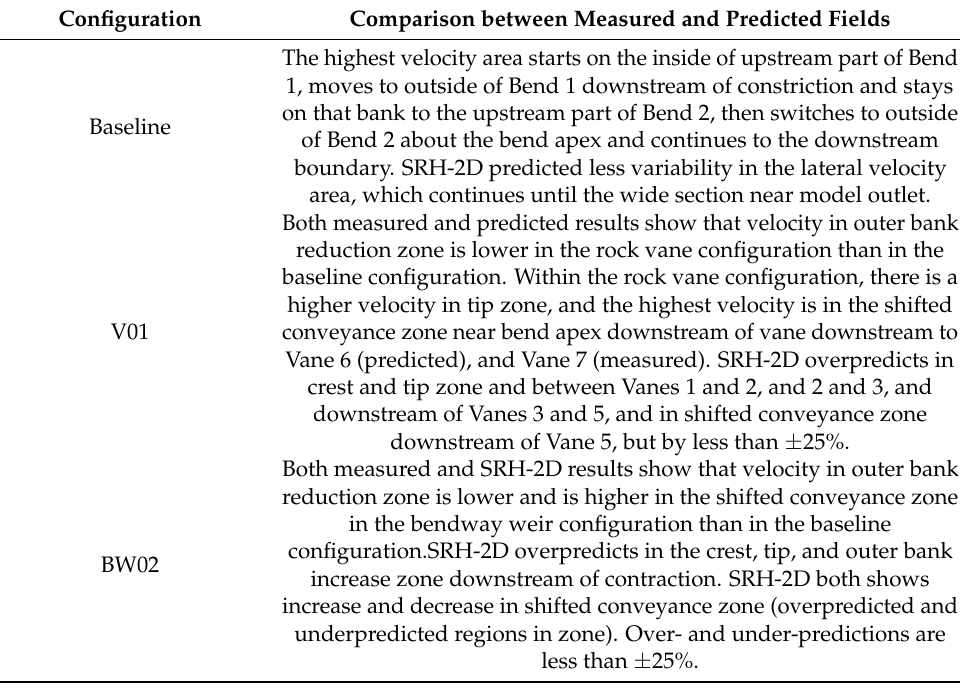
Table 8. Summary Comparison between Measured and Predicted Flow